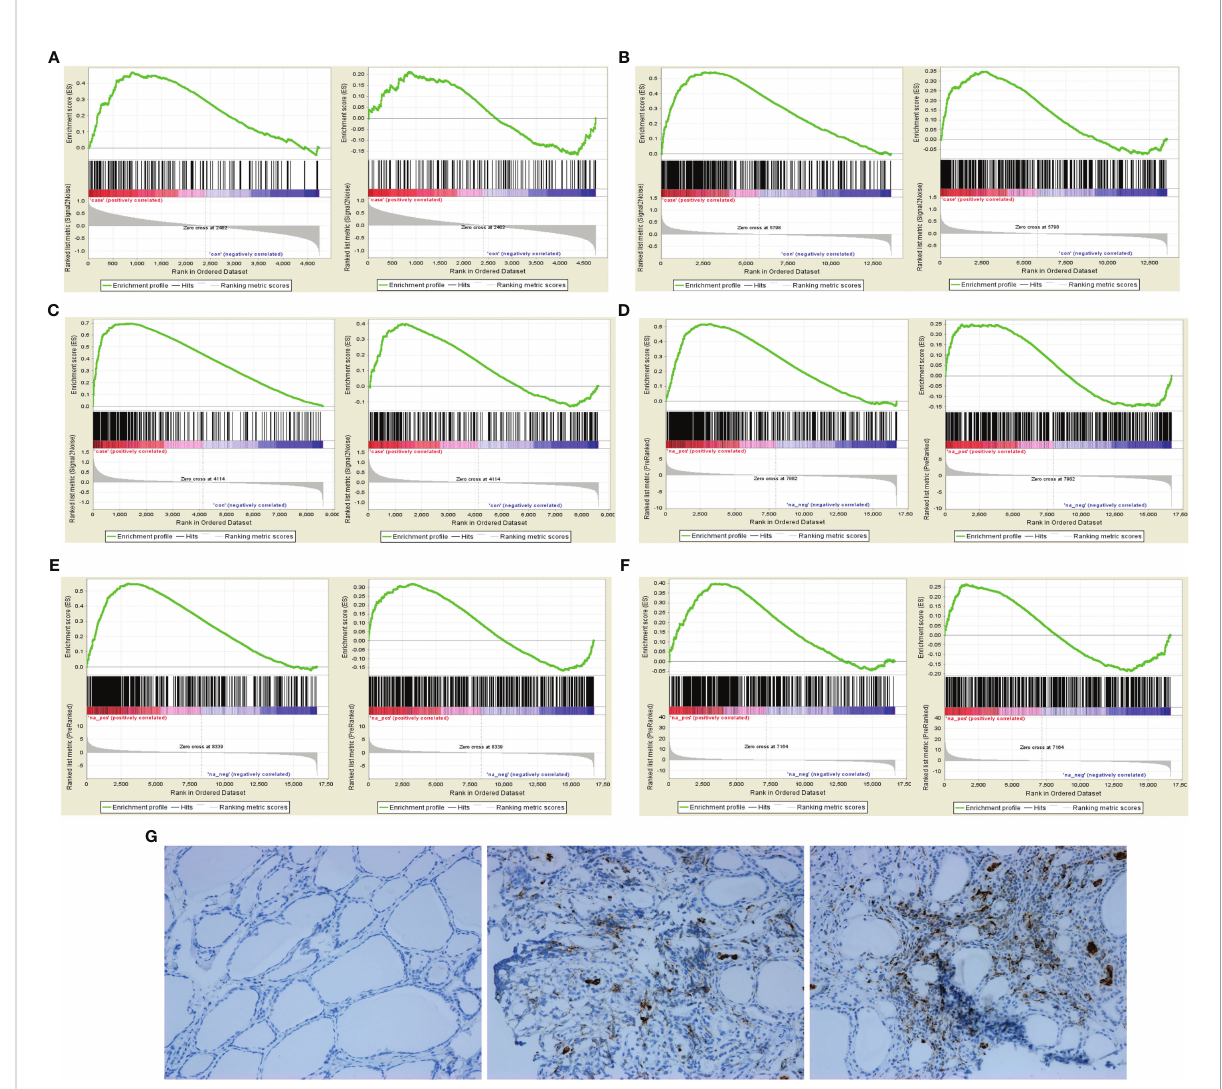
FIGURE 1 GSEA of macrophage polarization and immunohistochemical analysis in AITD patients. (A) In AITD thyroid tissue (From left to right: M1 and M2); (B) In GD thyroid tissue (From left to right: M1 and M2); (C) In HT thyroid tissue (From left to right: M1 and M2); (D) In CD14 + monocyte- macrophages of AITD patients (From left to right: M1 and M2); (E) In CD14 + monocyte-macrophages of GD patients (From left to right: M1 and M2); (F) In CD14 + monocyte-macrophages of HT patients (From left to right: M1 and M2); (G) Immunohistochemical results of CD68 in controls, HT and GD patients in